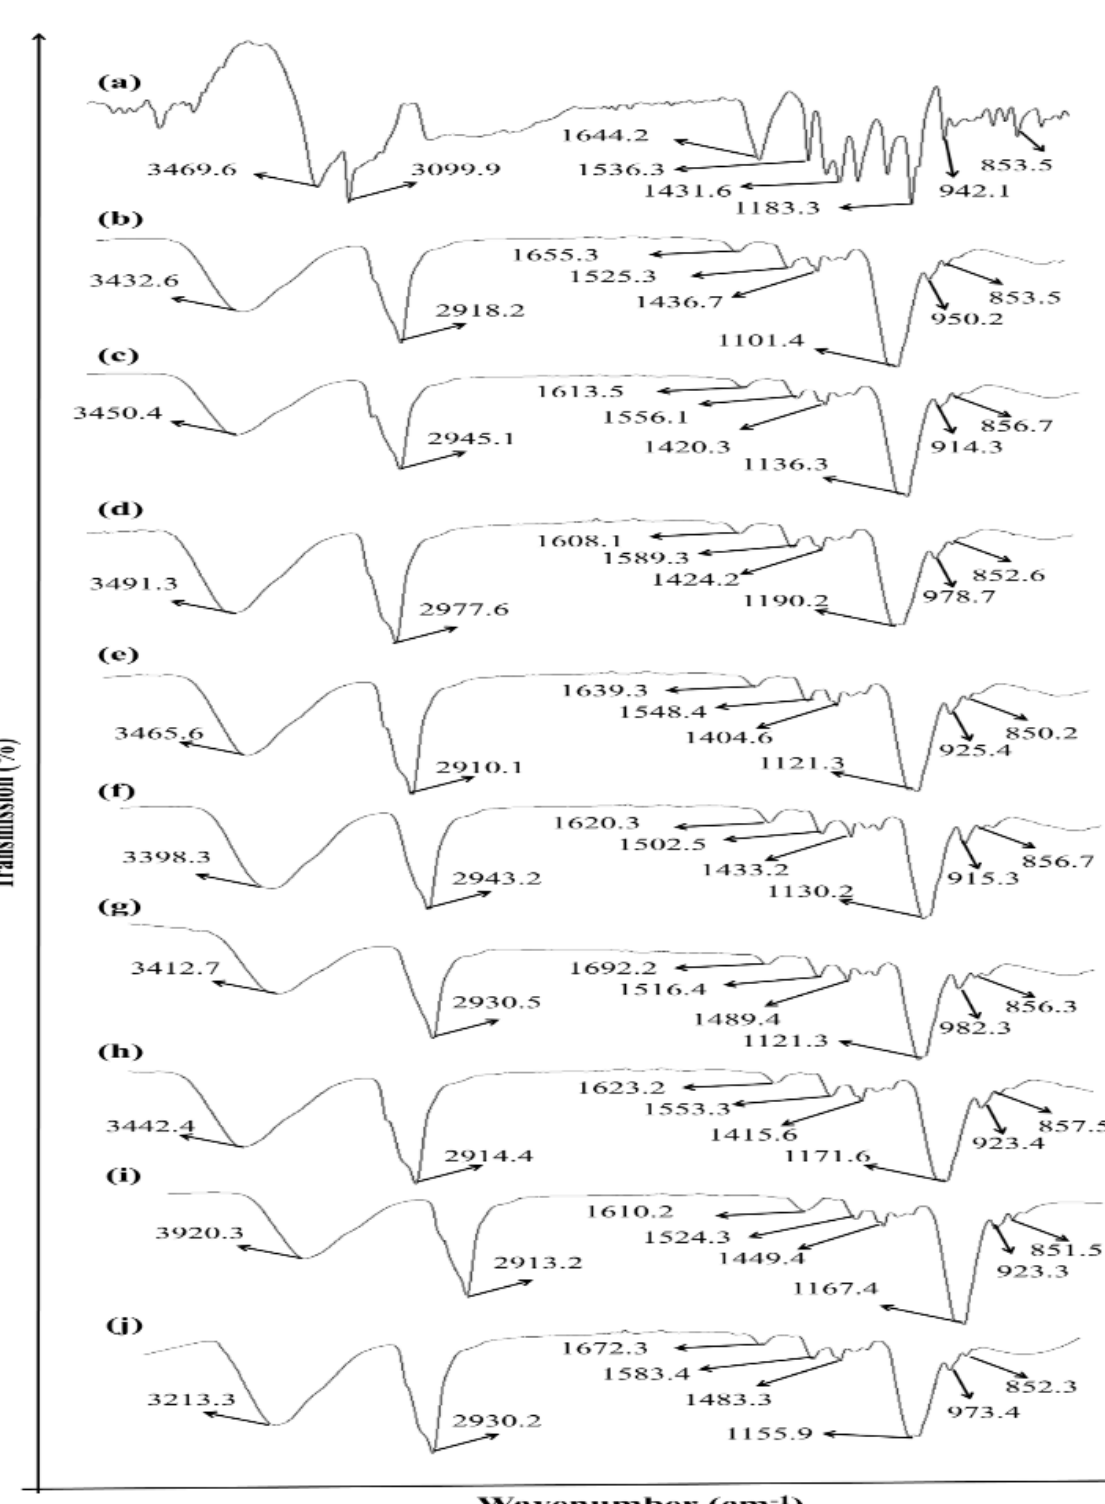
Figure 1. ATR–FTIR spectra: ( a ) MTX; ( b ) F1; ( c ) F2; ( d ) F3; ( e ) F4; ( f ) F5; ( g ) F6; ( h ) F7; ( i ) F8; ( j ) F9.